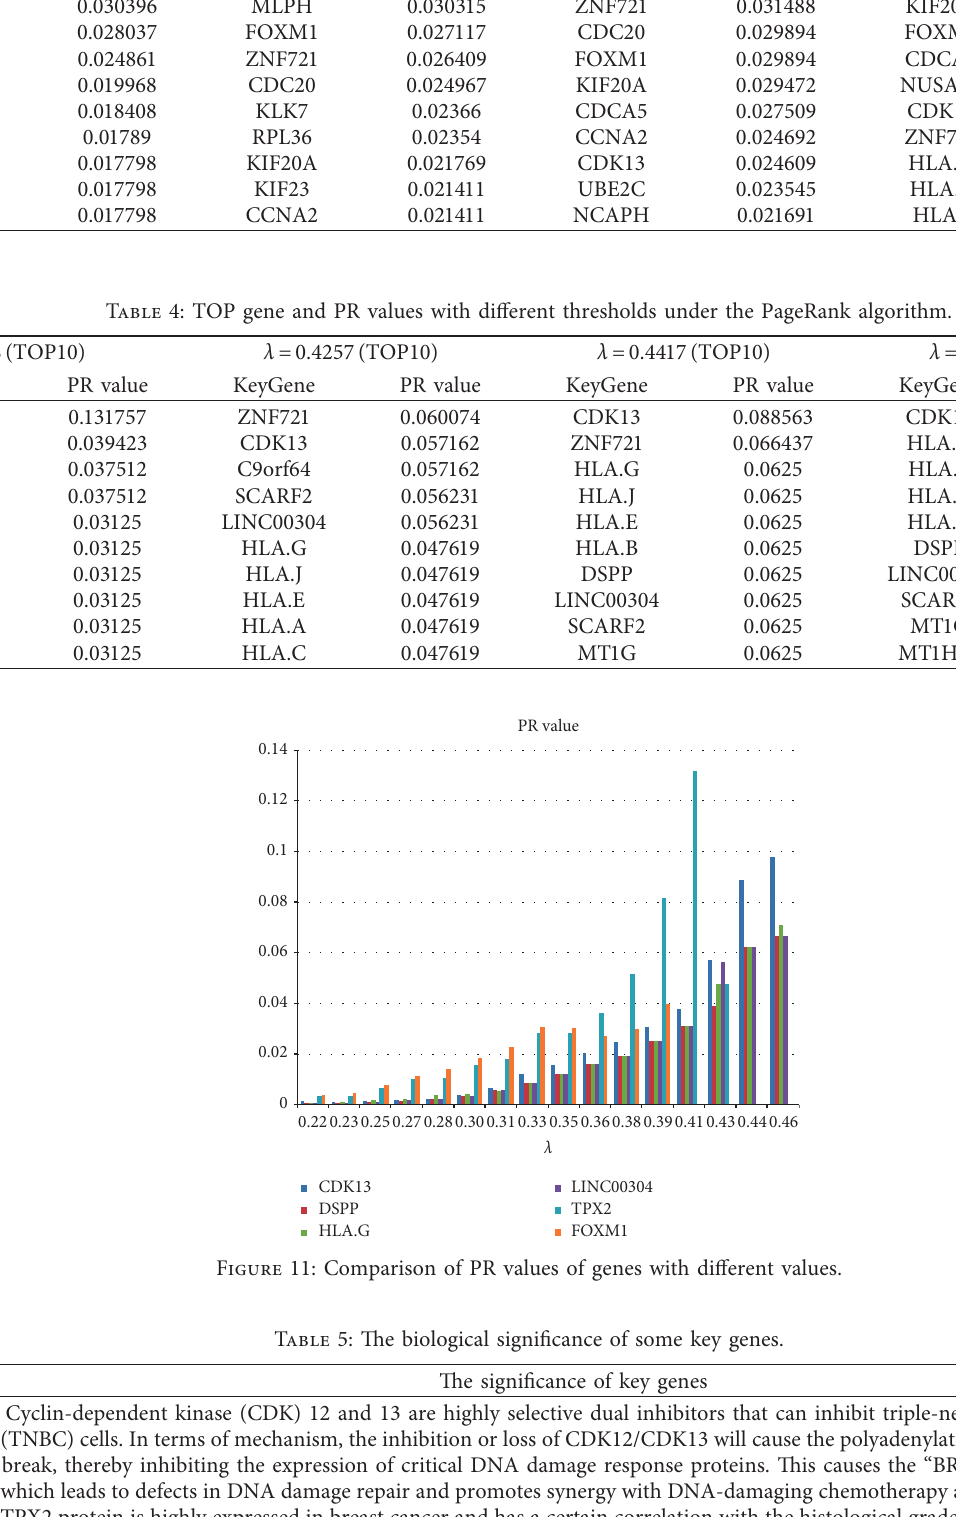
(TNBC) cells. In terms of mechanism, the inhibition or loss of CDK12/CDK13 will cause the polyadenylation sites of introns to break, thereby inhibiting the expression of critical DNA damage response proteins. This causes the “BRCAness” phenotype, which leads to defects in DNA damage repair and promotes synergy with DNA-damaging chemotherapy and PARP inhibitors. TPX2 protein is highly expressed in breast cancer and has a certain correlation with the histological grade of breast cancer and TPX2 lymph node metastasis. It may be a risk factor for the occurrence, development, and lymph node metastasis of breast cancer. FOXM1 is considered as an emerging molecular target with its carcinogenic effect and 85% high overexpression characteristics in FOXM1 TNBC. FOXM1 occupies an important position in the gene network and is a key regulatory gene for breast